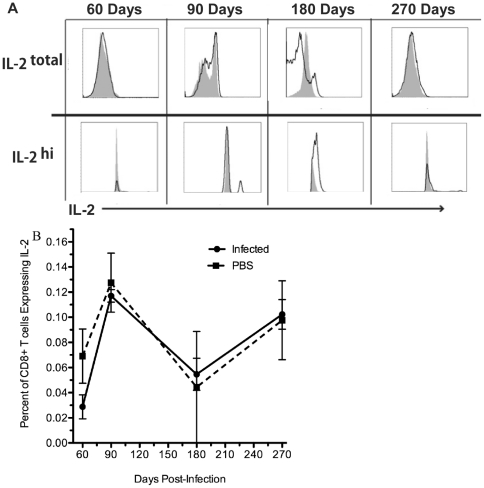
CD8+ T cell IL-2 expression.A) Histograms of IL-2 staining over time. Note the top row shows the total IL-2 expression while the bottom row examines the subtle differences of IL-2 expression between uninfected and infected mice. The black line represents splenocytes from infected mouse pulsed with B. melitensis specific peptide. The shaded grey region represents splenocytes from an uninfected age-matched mouse pulsed with B. melitensis specific peptide. B) Percent of CD8+ T cells expressing IL-2 in infected and non-infected mice.